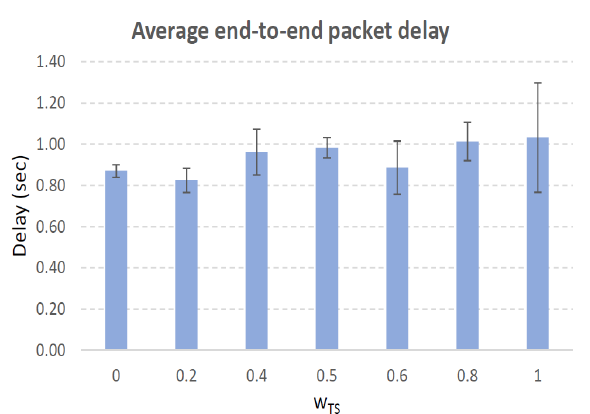
Figure 19. Average end-to-end packet delay. Scenario with very high social media interaction (TS normal distribution with µ = 4 and σ = 1). Nodes’ density = 200 nodes/km 2